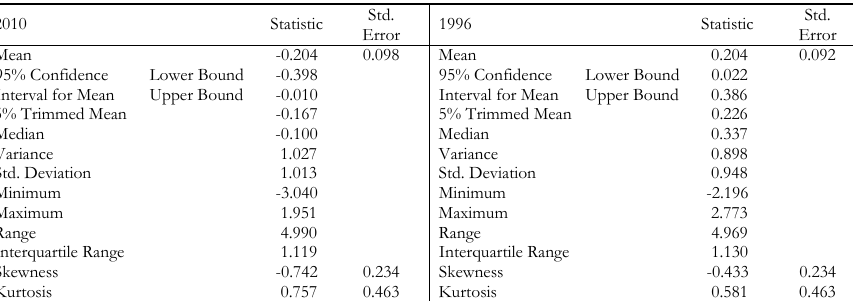
Distribution of scores for factor 3 – Population structure